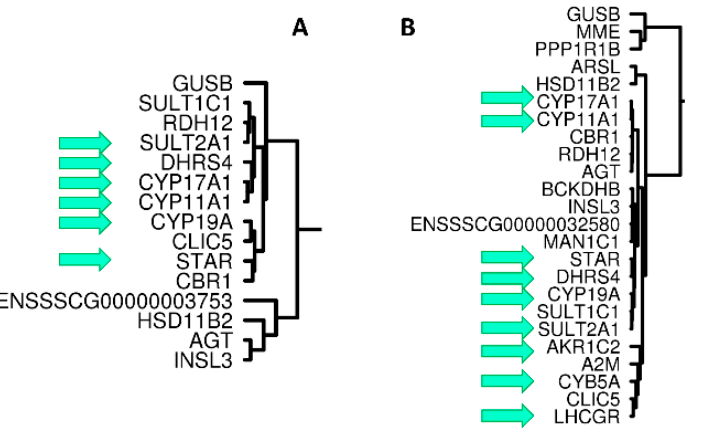
Figure 2. Part of HCA of mRNAseq-P ( A ) and from mRNAseq-PLW ( B ). Among more than